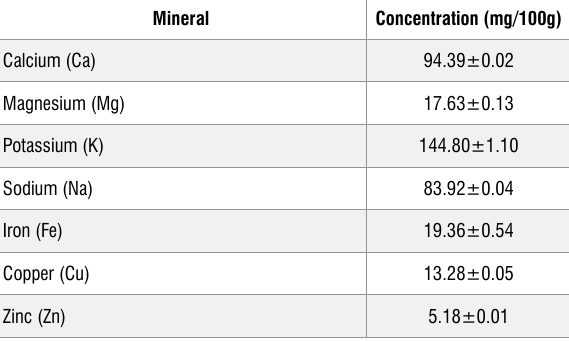
Mineral content of yellow variety of tiger nut